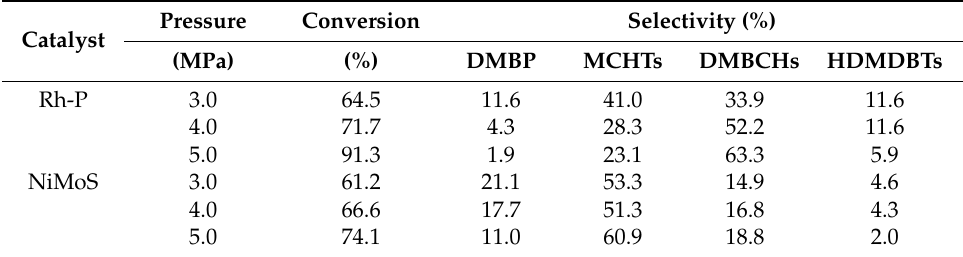
Table 4. Product selectivity in the HDS of 4,6-DMDBT over Rh-P and NiMoS catalysts at 310 ◦ C.